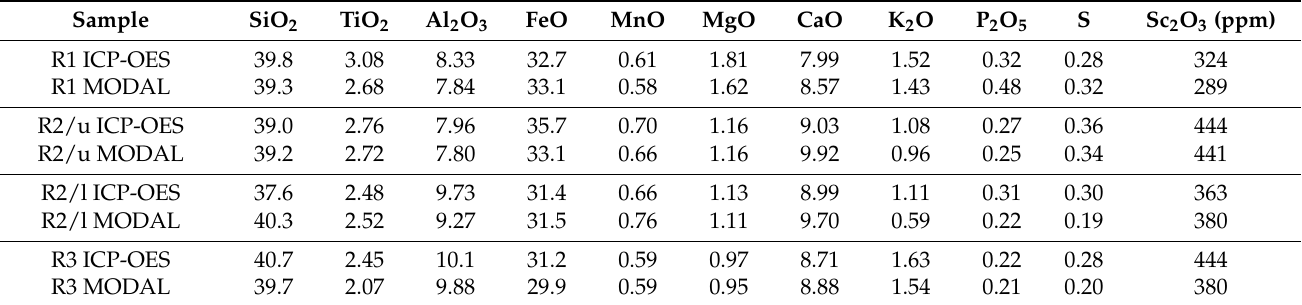
Table 3. Chemical compositions of concentrates used in high-temperature experiments. Compositions calculated based on modal mineralogy are also provided for comparison. Sc 2 O 3 presented in ppm, other oxides in wt%.